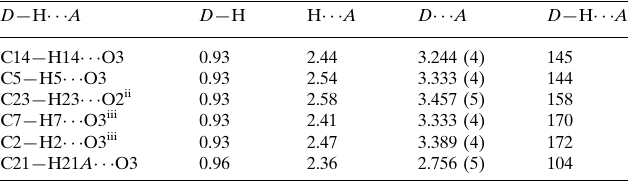
Hydrogen-bond geometry (A˚ , (cid:2)